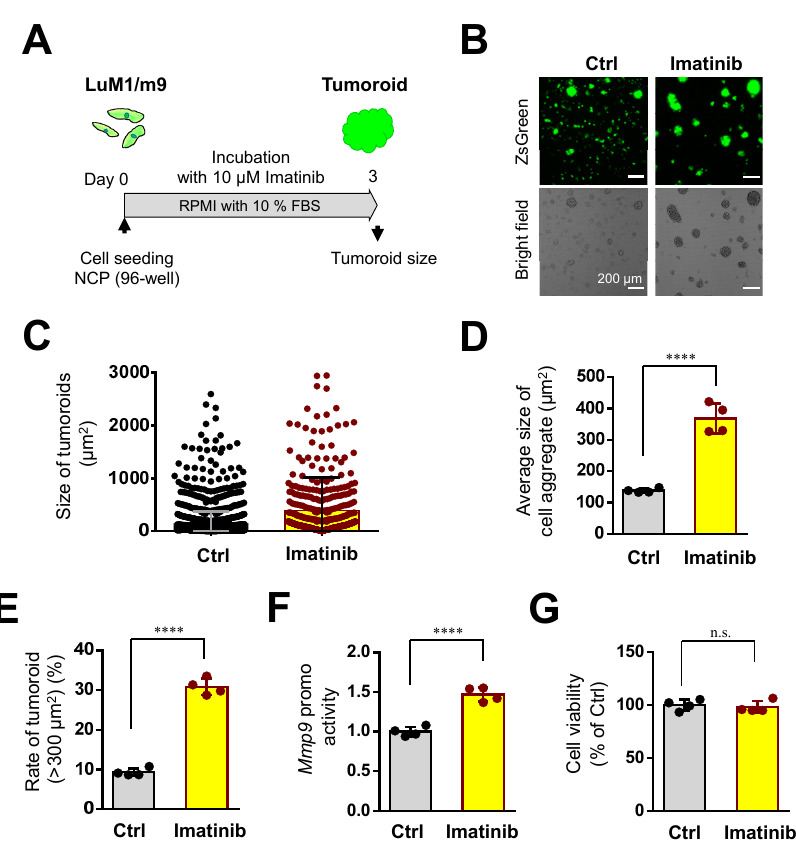
Figure 6. Imatinib promoted the tumoroid growth of mCRC: ( A ) a scheme of the experimental protocol used for panel ( B – G ). LuM1/m9 cells were cultured with 10 μ M Imatinib for 3 days in a medium containing 10% FBS; ( B ) representative images of cell-aggregates with or without Imatinib. Scale bars, 200 μ m; ( C ) column scatters plotting of tumoroid size. Representative data from a single well were shown; ( D ) the average size of cell aggregates or tumoroids. n = 4 independent culture wells; ( E ) the rate of tumoroids larger than 300 μ m 2 . n = 4 independent culture wells; ( F ) Mmp9 promoter activity. n = 4 independent culture wells; ( G ) and cell viability. n = 4 independent culture wells. **** p < 0.0001, n.s., not significant.